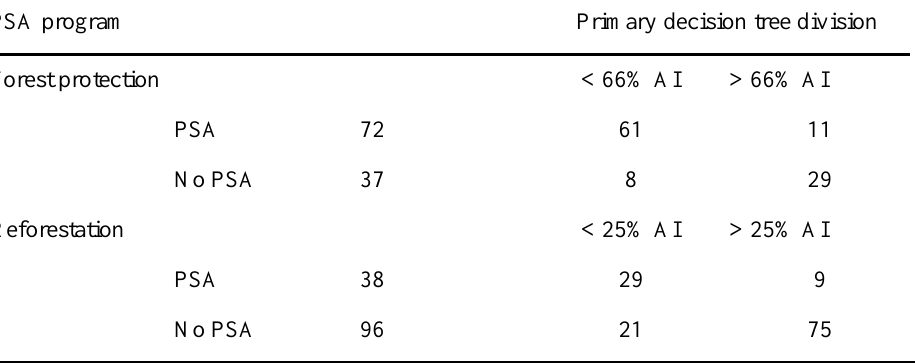
Table 2 . The number of landowners with PSA (payment for environmental services) contracts for forest protection or reforestation, compared to the number of landowners eligible for these PSA programs. Landowners with more than 2 ha of forest land were considered eligible for the forest protection PSA program, and landowners with more than 1 ha of pasture or charral were considered eligible for the reforestation PSA program. Data are further broken down by the primary factor dividing PSA participants from nonparticipants as determined by decision tree analyses. The “break point” for farm dependence, i.e., the percentage of landowner income from agricultural activities on the farm, in each PSA program is determined through the analysis and, as a result, varies between programs. AI stands for agricultural